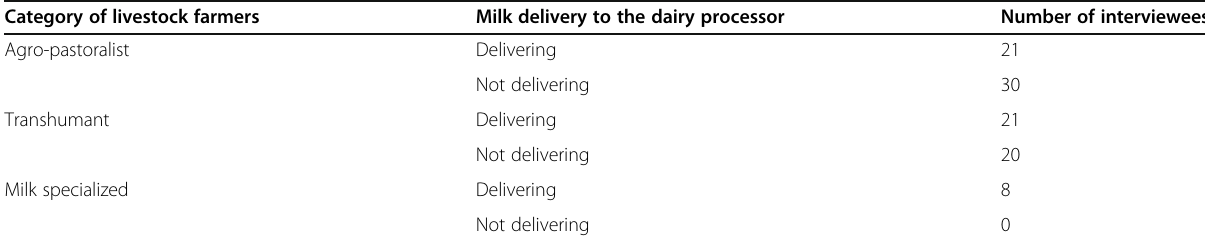
Category of livestock farmers Milk delivery to the dairy